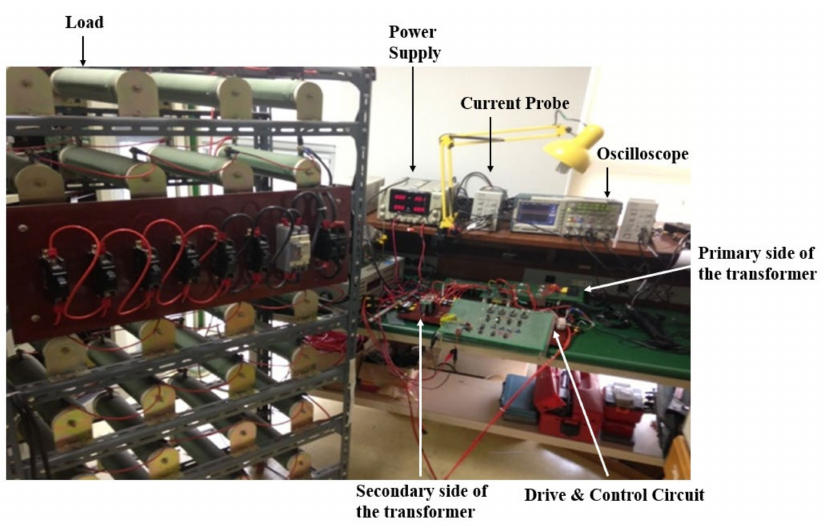
Figure 12. Laboratory prototype (600 W) of the proposed converter.